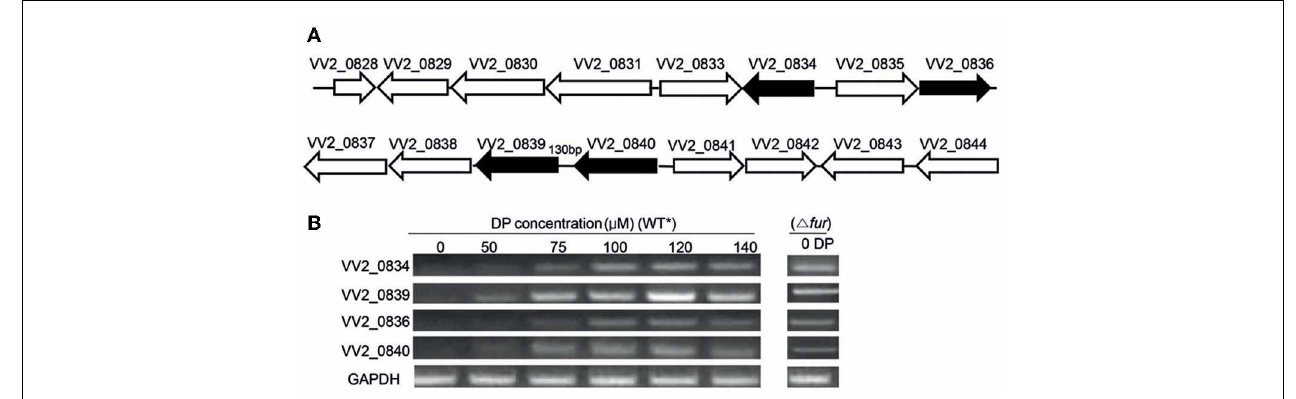
FIGURE 1 | Gene organization and expression under various iron concentrations. (A) Organization of Open Reading Frames (ORFs) in the vulnibactin biosynthetic gene cluster located on chromosome 2 of V. vulnificus. ORFs filled in black represent the genes of focus in the